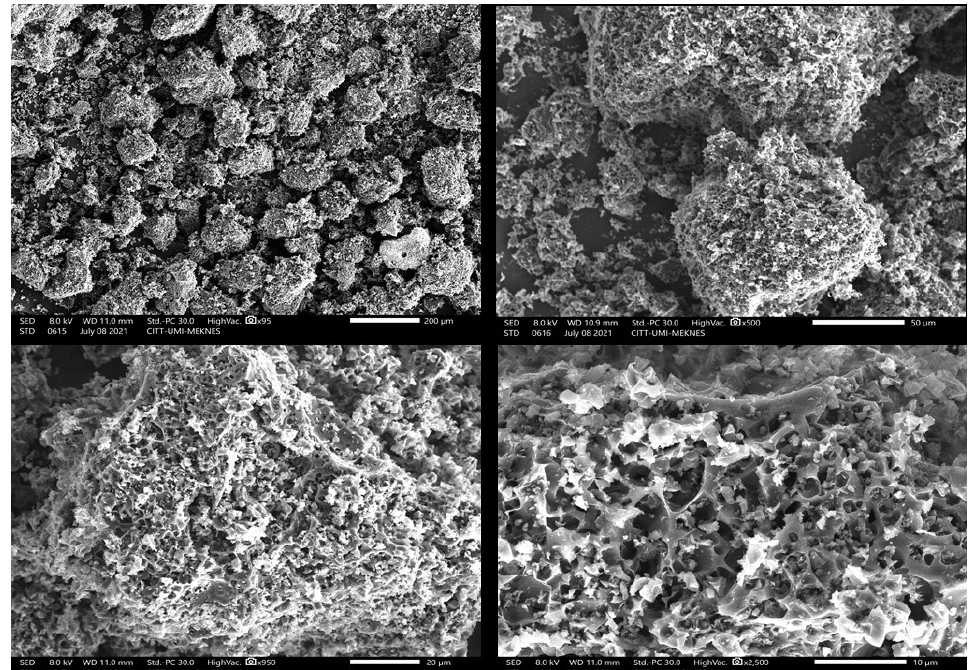
Figure 2. XRD spectra of SCGs, ACSCGs and CAC.